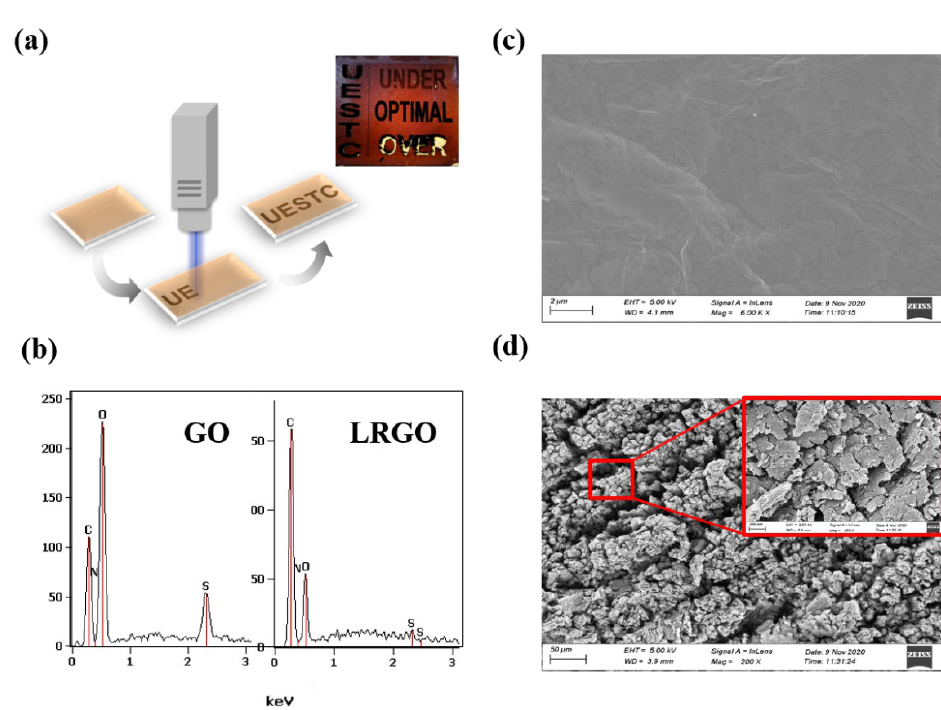
Figure 1. ( a ) Illustration of LRGO’s fabrication, inside of ( a ) is the photo of GO; over treatment − LRGO (20 times fabrication LRGO with scanning speed is 750 mm/s); optimal treatment − LRGO (15 times fabrication LRGO with scanning speed is 750 mm/s); under treatment − LRGO (5 times fabrication LRGO with scanning speed is 750 mm/s) and UESTC letter pattern. ( b ) EDS image of GO and LRGO. ( c ) SEM image of GO. ( d ) SEM image of 20 times fabrication LRGO.